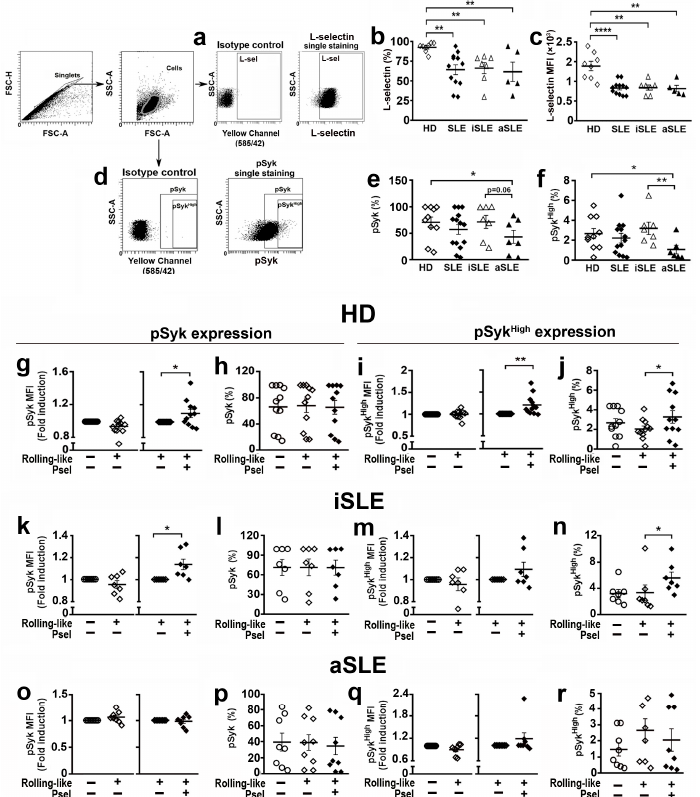
Figure 6. Expression of L-selectin and pSyk in neutrophils from healthy donors and SLE patients in experimental conditions. ( a , d ) Gating strategy for identification of ( a ) L-selectin, and ( d ) pSyk and pSyk High populations: Singlets were identified by FSC-H and FSC-A criteria. Neutrophil populations were identified in the singlets gate by SSC-A/FSC-A criteria. Gates for positive cells were identified by using isotype controls. ( b , c ) L-selectin expression in basal experimental conditions: ( b ) Percentage of cells expressing L-selectin, and ( c ) MFI of L-selectin. ( e , f ) Percentage of neutrophils expressing ( e ) pSyk or ( f ) pSyk High in basal experimental conditions. ( g – j ) pSyk and pSyk High expression in HD neutrophils in rolling-like conditions: ( g ) MFI fold induction of pSyk, ( h ) Percentage of pSyk expressing neutrophils, ( i ) MFI of pSyk High , and ( j ) Percentage of pSyk High expressing neutrophils. ( k – n ) pSyk and pSyk High expression in iSLE neutrophils in rolling-like conditions: ( k ) MFI fold induction of pSyk, ( l ) Percentage of pSyk expressing neutrophils, ( m ) MFI fold induction of pSyk High , and ( n ) Percentage of pSyk High expressing neutrophils. ( o – r ) pSyk and pSyk High expression in aSLE neutrophils in rolling-like conditions: ( o ) MFI fold induction of pSyk, ( p ) Percentage of pSyk expressing cells, ( q ) MFI fold induction of pSyk High , and ( r ) Percentage of pSyk High expressing neutrophils. Data are presented as MFI fold induction or percentage ± SEM. Statistical analysis was performed using paired Student’s t -test and Wilcoxon test. * p ≤ 0.05; ** p ≤ 0.01, **** p ≤ 0.0001. HD ( n = 7–12). iSLE patients ( n = 7), aSLE patients ( n = 7–8). MFI: Mean fluorescence intensity. HD: Healthy donor. SLE: Systemic Lupus Erythematosus. iSLE: inactive SLE. aSLE: active SLE. SLE: Total population of patients included. Open circles: basal conditions. Open diamonds: rolling-like on BSA. Black diamonds: rollink-like on